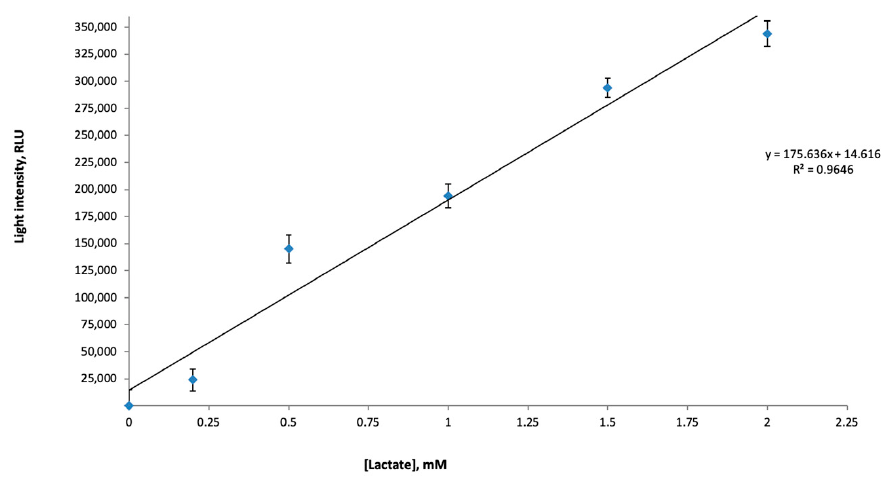
Figure 7. Light intensity values of the multi-enzyme system in the presence of the salivary lactate concentrations mentioned in the published articles.